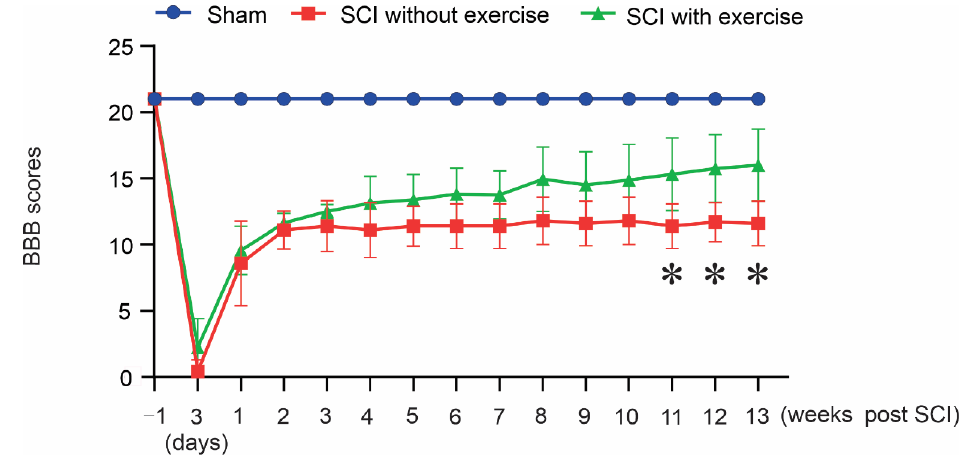
Figure 2. Locomotor exercise promotes recovery of hindlimb function. Improved BBB locomotor recovery found at weeks 11, 12, and 13 in the group that received locomotor exercise (*: p < 0.05).